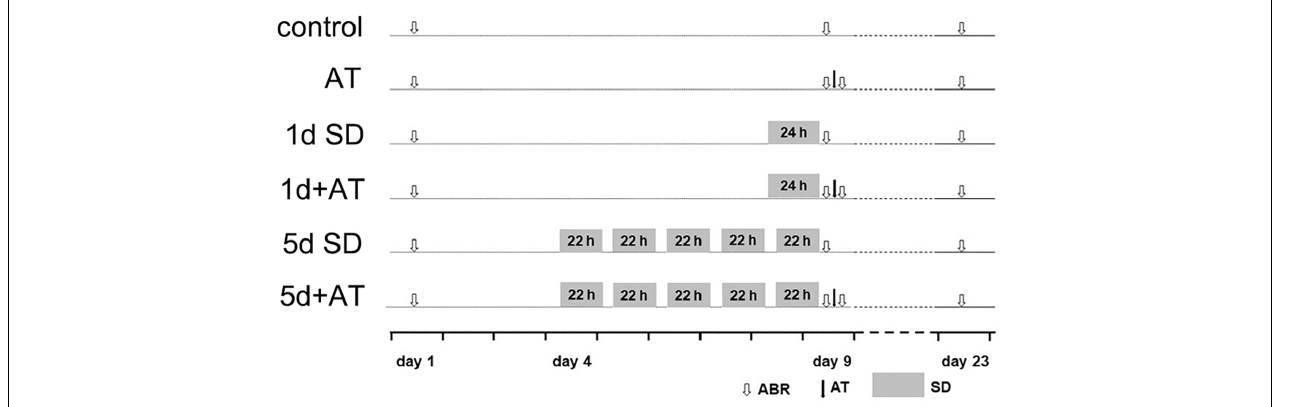
FIGURE 1 | Experimental procedure for animals. Experimental timeline for six groups: control (sham SD followed by sham AT), AT (sham SD followed by AT), 1d SD (1d SD followed by sham AT), 1d + AT (1d SD followed by AT), 5d SD (5d SD followed by sham AT), 5d + AT (5d SD followed by AT). ABR, auditory brainstem response